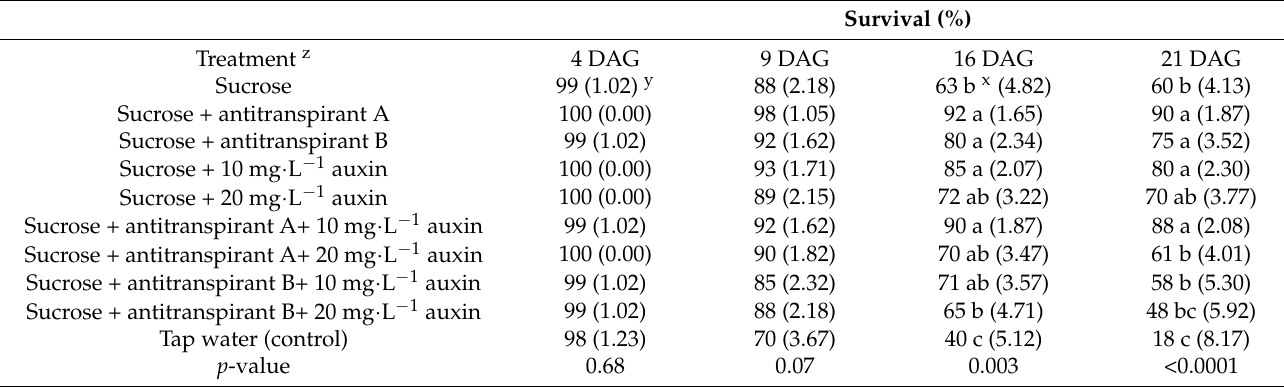
Table 2. Survival (%) of grafted watermelon transplants measured at 4, 9, 16, and 21 days after grafting (DAG) at Mount Vernon, WA, USA. Prior to grafting, rootstock seedlings received applications of sucrose, antitranspirant, and auxin treatments. Grafting was carried out for trials 1, 2, and 3 on 5 March, 15 March, and 23 April 2020, respectively, and data were combined ( p =